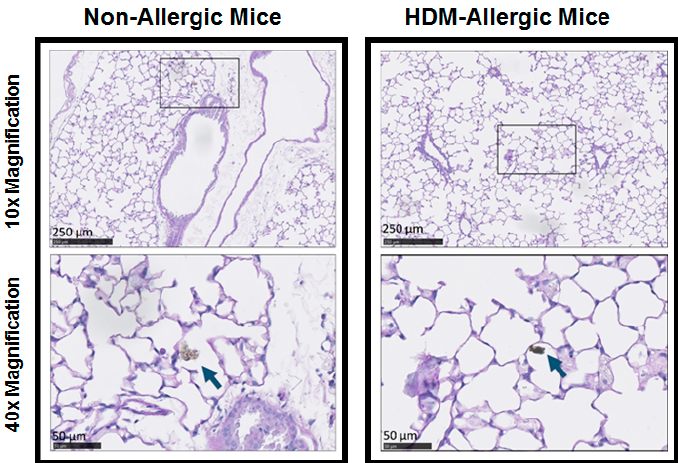
Figure 2. Deposition of agglomerate particles in alveolar ducts following exposure to GDI engine exhaust. Deposition was observed in saline- (left) and HDM (right)-treated animals. Particle agglomerates are indicated by blue arrows. High power images (40× magnification) are representative of the boxed regions in the low power images (10× magnification).